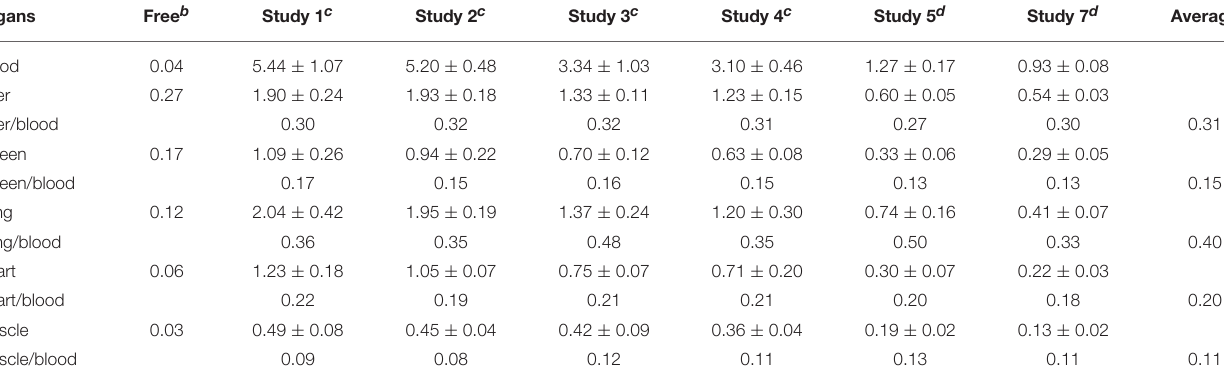
TABLE 1 | Percent levels (%ID/g) of 99m Tc-MORF effector in blood and several normal organs at 3h post its IV injection to pretargeted mice and the organ to blood ratios of the antibody-bound effector a .